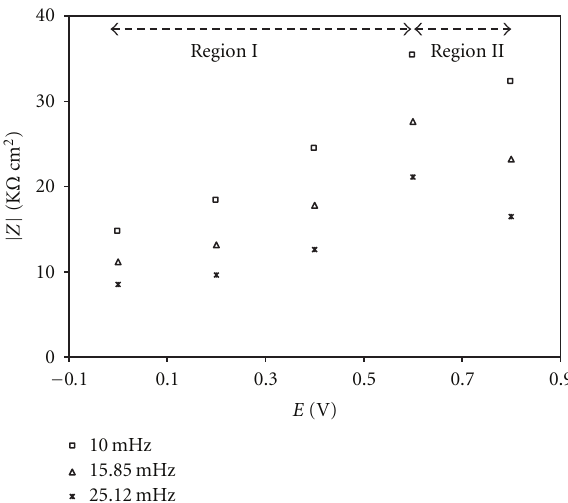
Figure 4: E ff ect of film formation potential on impedance magni- tude of AISI 321 stainless steel in 0.5MH 2 SO 4 at low